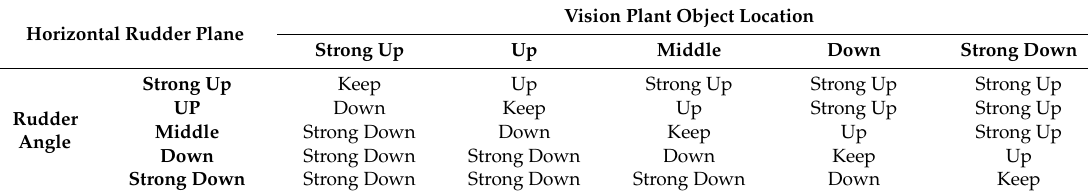
Table 3. Rules for the horizontal rudder plane.